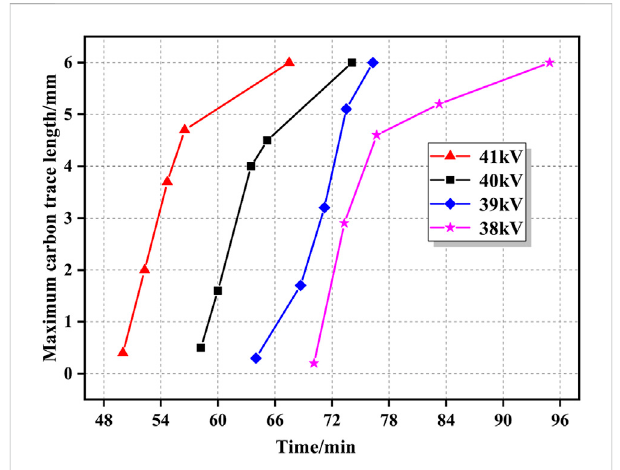
FIGURE 7 Trend of maximum carbon trace length with time at different applied